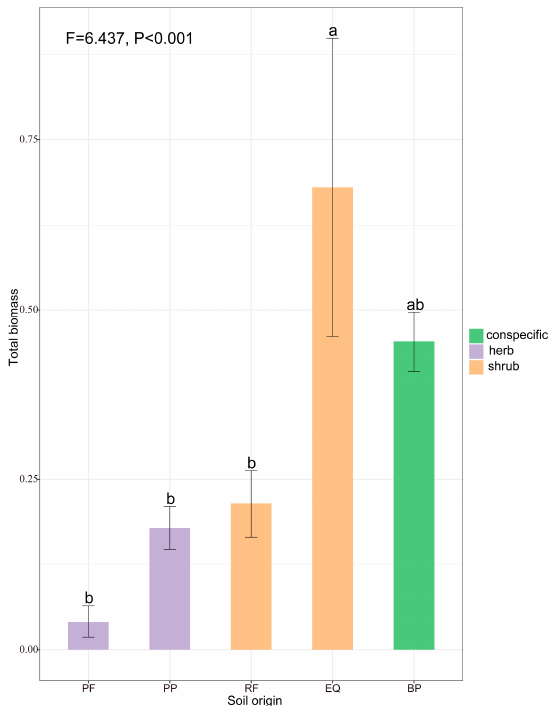
Figure 4. The total biomass (g) of Betula platyphylla in soil conditioned by herbs (PP, PF), shrubs (EQ, RF), and conspecifics (BP). PP, Poa poophagorum ; PF, Potentilla fragarioides ; RF, Rhododendron fortunei ; EQ, Enkianthus quinqueflorus ; BP, Betula platyphylla . Values shown in the figure are mean values ± SE (n = 10). Different lowercase letters refer to significant differences at p < 0.05.